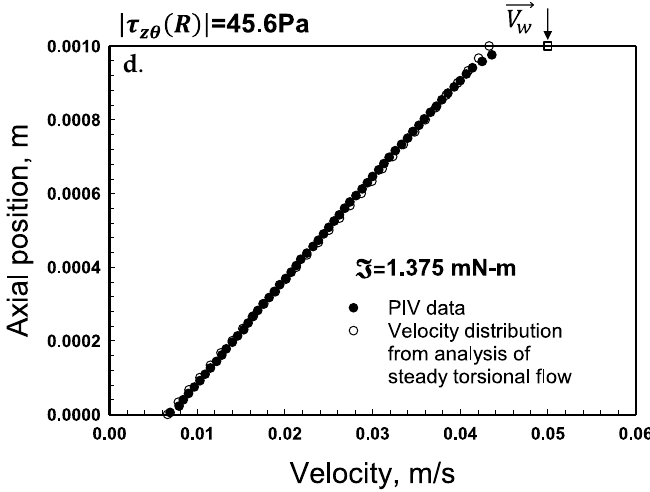
Figure A3. Velocity distributions with wall slip in steady torsional flow using parallel disks for the gap, H = 1.0 mm for the shear stress at the edge values of ( a ) 35.9 Pa, ( b ) 38.2 Pa, ( c ) 40.6 Pa, ( d ) 45.6 Pa. The PIV data are from Medina-Bañuelos et al., 2021. Filled symbols are from PIV data and unfilled are from calculations.